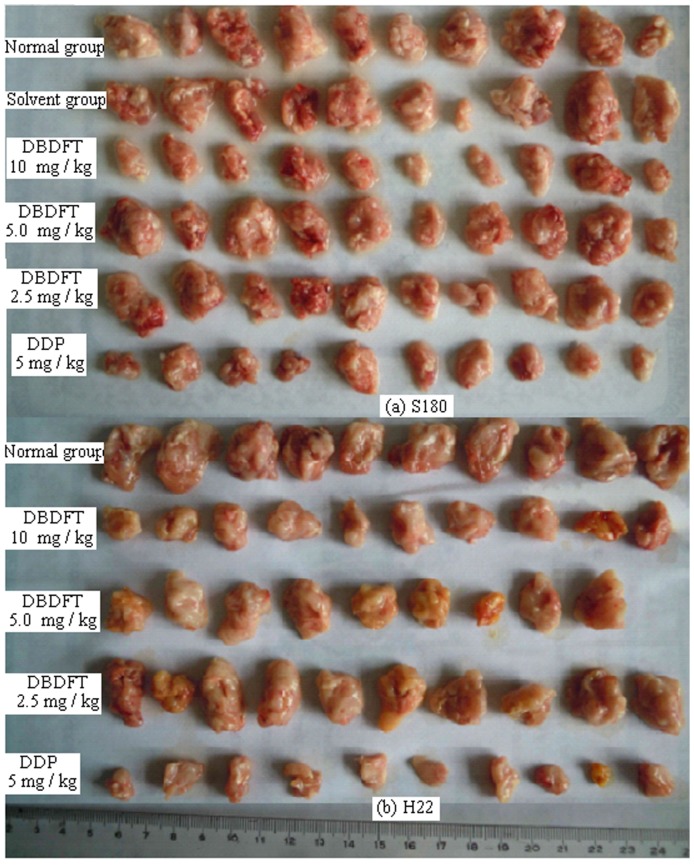
DBDFT inhibits the growth of tumor in mice implanted with S180 and H22 cancer.Mice were treated every day via tail vein with DBDFT and cisplatin for 10 consecutive days. Images of the subcutaneous tumors de rived from the S18 and H22 mice are shown. (a) S18 mice; (b) H22 mice (means±SD).